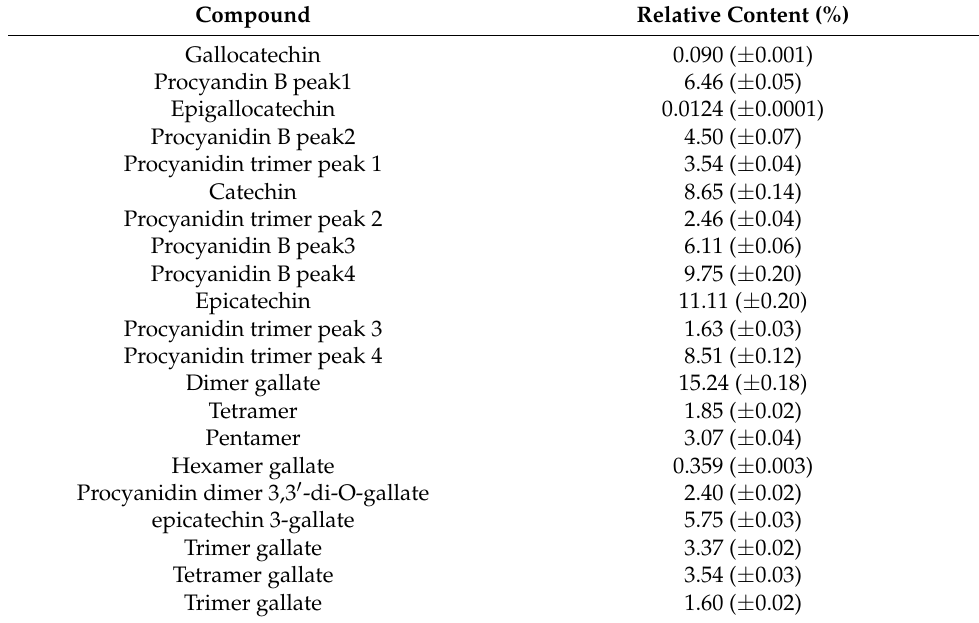
Table 7. Relative content of flavanols in the EtOH-H 2 O extract. The % was determined by measuring the peak area of each compound in respect to the sum of the peak areas of all the identified